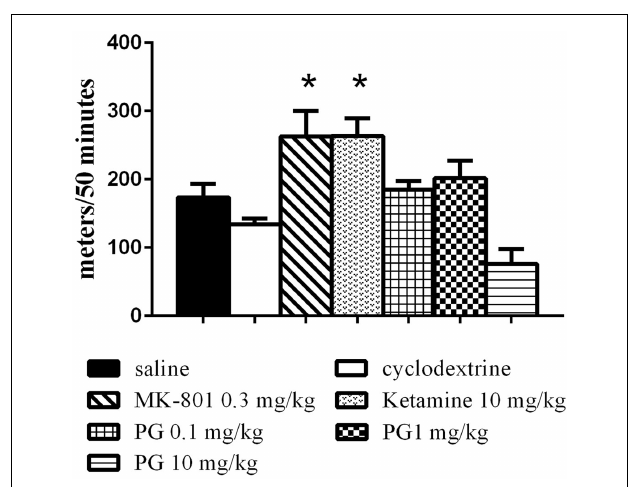
FIGURE 1 | Locomotor activity in the open field was assessed by placing an animal in the arena immediately after i.p. application of PG, MK-801, ketamine, and their vehicles . Locomotor activity was monitored over 50min. Ketamine and dizocilpine administration resulted in hyperlocomotion. Animals treated with these non-competitive NMDA antagonists significantly increased distance traveled. PG administration did not lead to significant changes in locomotion. All values represent group means ± SEM. * p < 0.05 compared to the saline group.